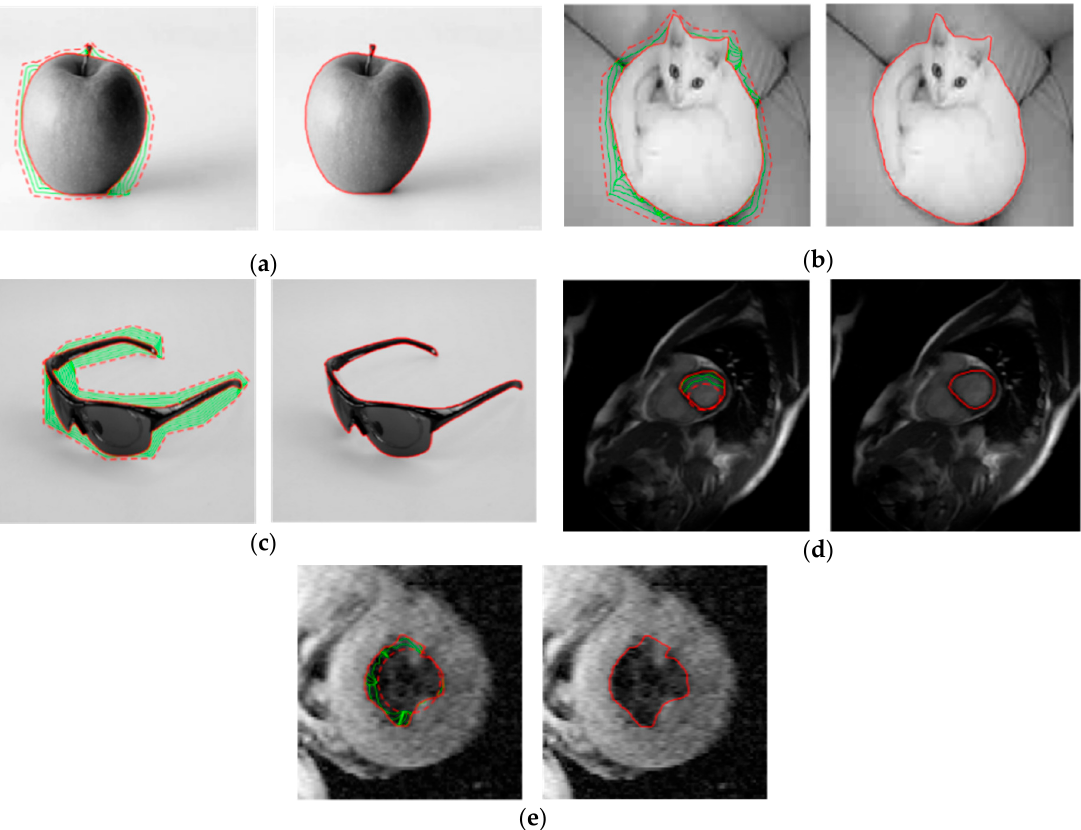
Figure 16. Evolution of the contour and segmentation results of natural images and medical images using proposed method.